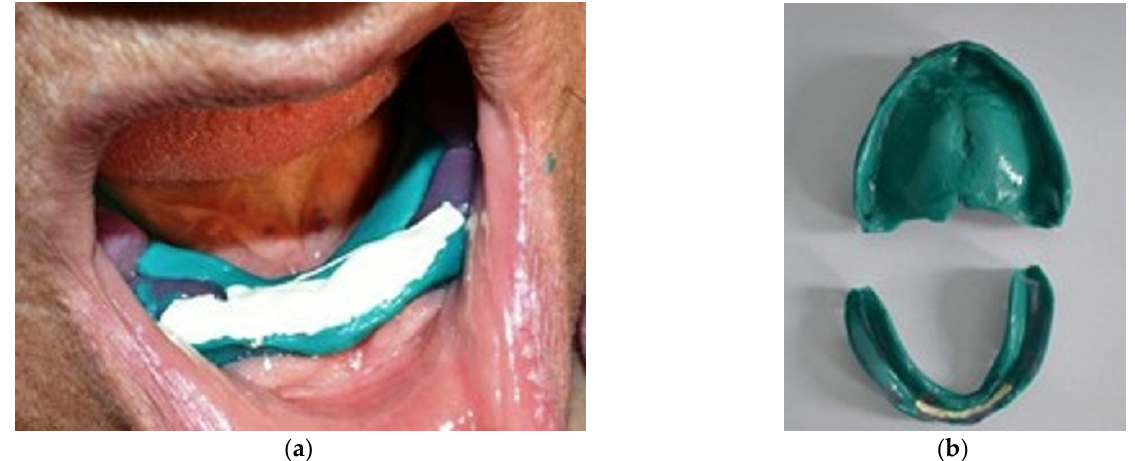
Figure 11. Final impressions ( a ) The appearance of the final mandible impression; ( b ) Appearance of the two final im- pressions.